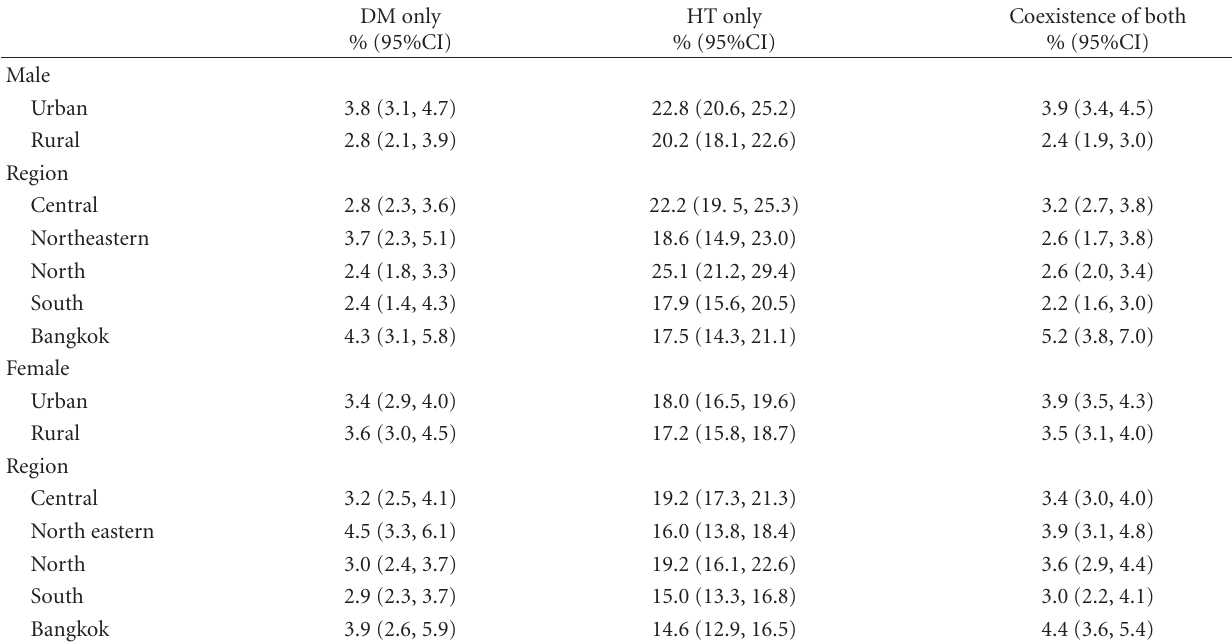
Table 2: Prevalence (95%CI) of diabetes, hypertension and coexistence of both conditions by area of residence and region in Thai population aged ≥ 15 years.